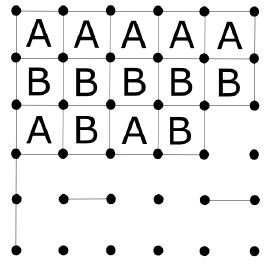
Figure 9. Starting node State S.